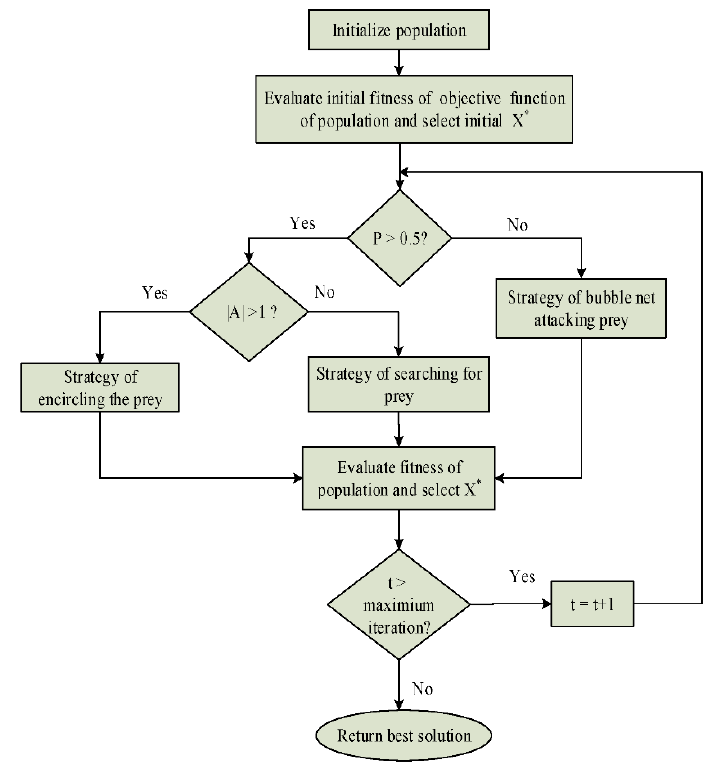
Figure 5. WOA flowchart [38].